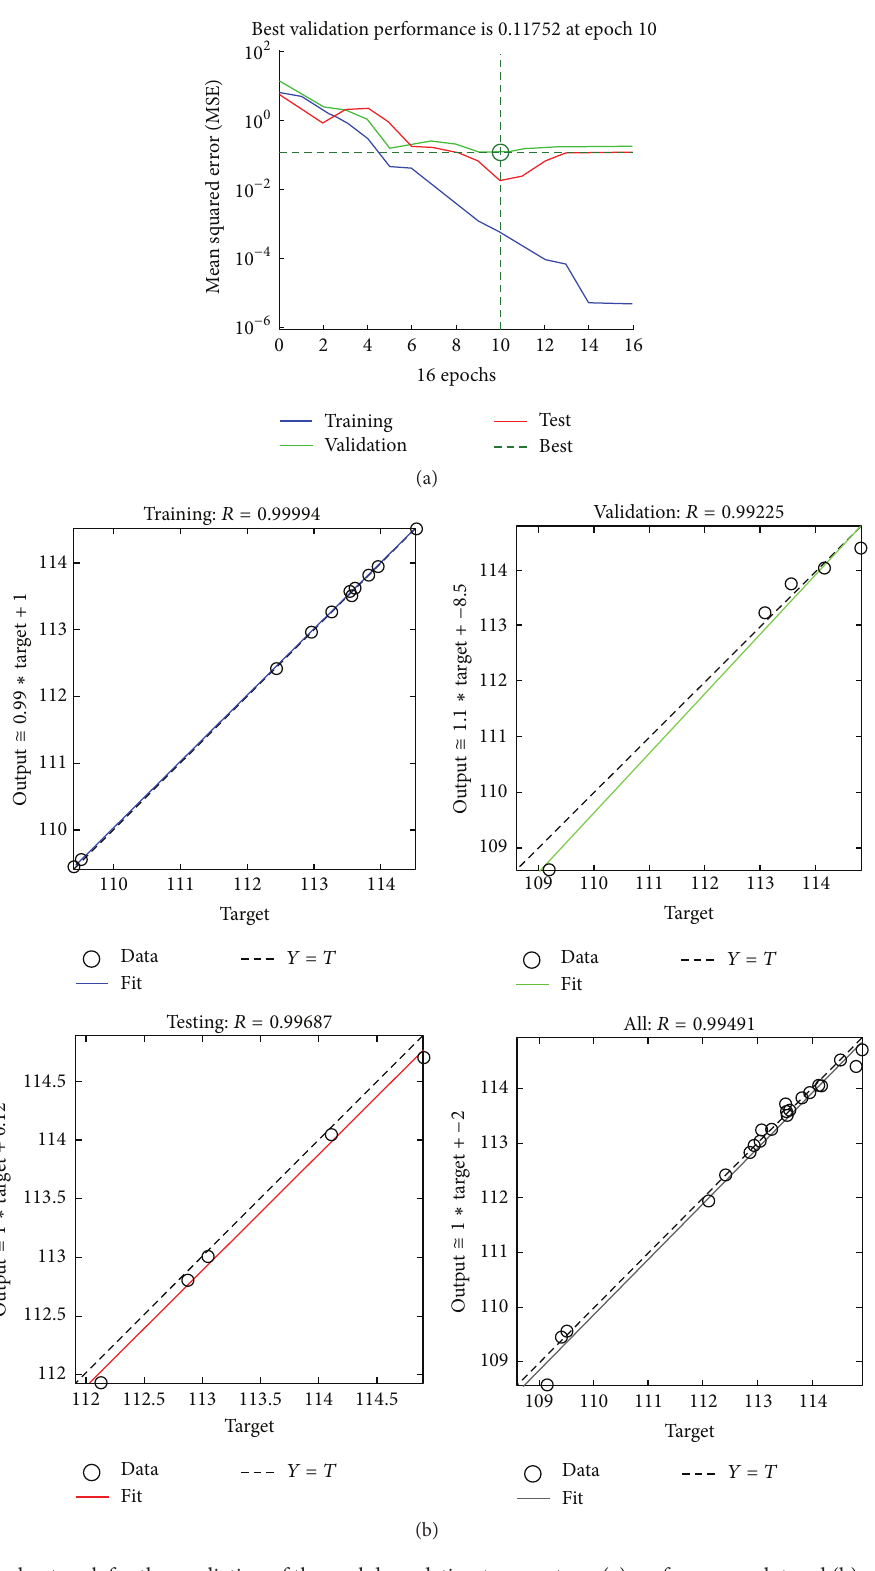
Figure 10: Neural network for the prediction of thermal degradation temperature: (a) performance plot and (b) regression